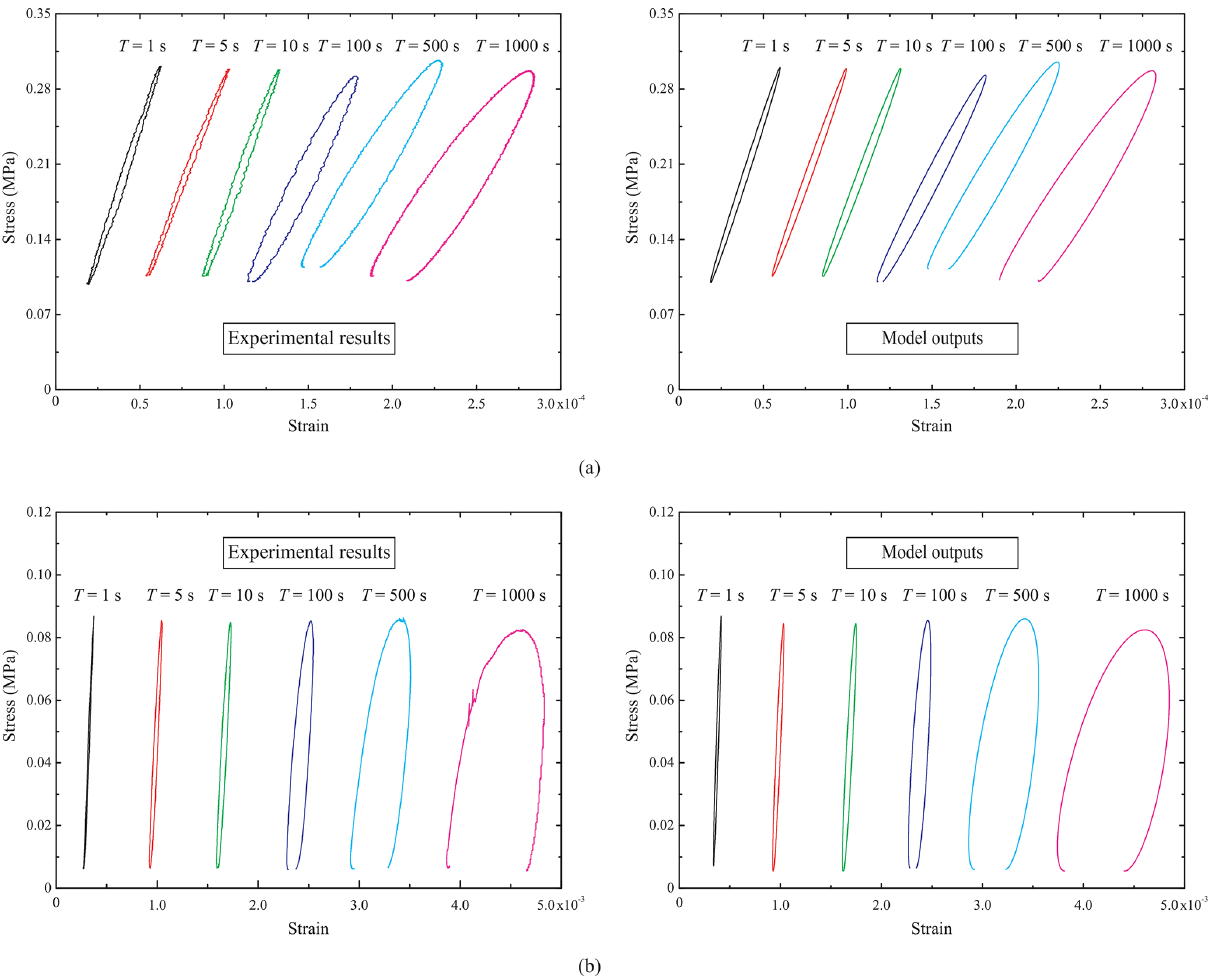
Figure 14. Comparison between the steady-state stress–strain hysteresis loops measured in the experiments and those predicted by the dislocation-based model for (a) specimen Dry-5ppt-1, tested with stresses varying from 0.1 to 0.3MPa and with a temperature of − 10 ◦ C, and (b) specimen Floating-5ppt-1, tested with stresses varying from 0.005 to 0.085MPa and with an average temperature of − 2 . 5 ◦ C (note that, to compare the representative hysteresis loops in all the different-frequency experiments with those outputted by the model in a more concise and intuitive way, the prestrains before the hysteresis loops drawn here are not equal to the experimental